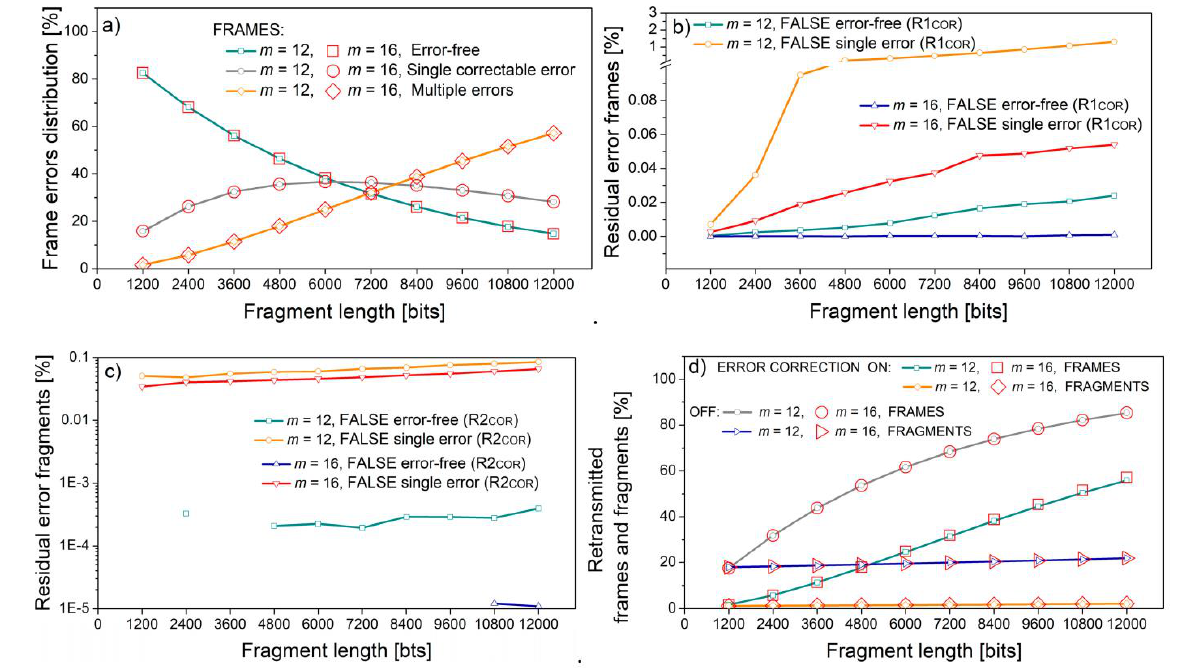
Figure 10. Frame and fragment error events as a function of fragment lengths; increment of 1,200 bits is equal to 400 m = 12 symbols, and to 75 m = 16 symbols; ( a ) Frame error events distribution; ( b ) residual errors in frame; ( c ) residual errors in fragments; ( d ) retransmitted frames and fragments.